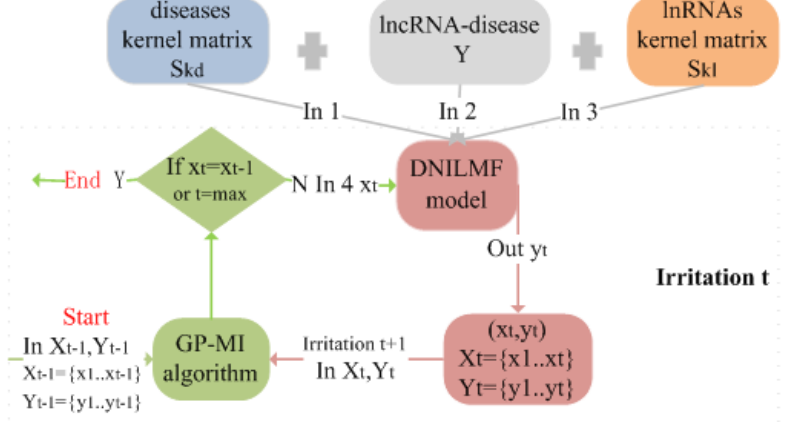
Figure 2. The optimization process of GP-MI for the DNILMF model parameters. At irritation t: Step 1